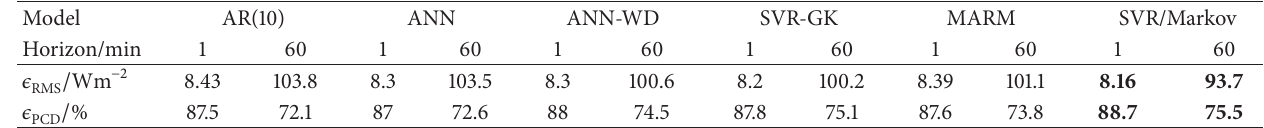
Table 9: Obtained average prediction values for ten days selected from July to August of 2000 ( summer ).